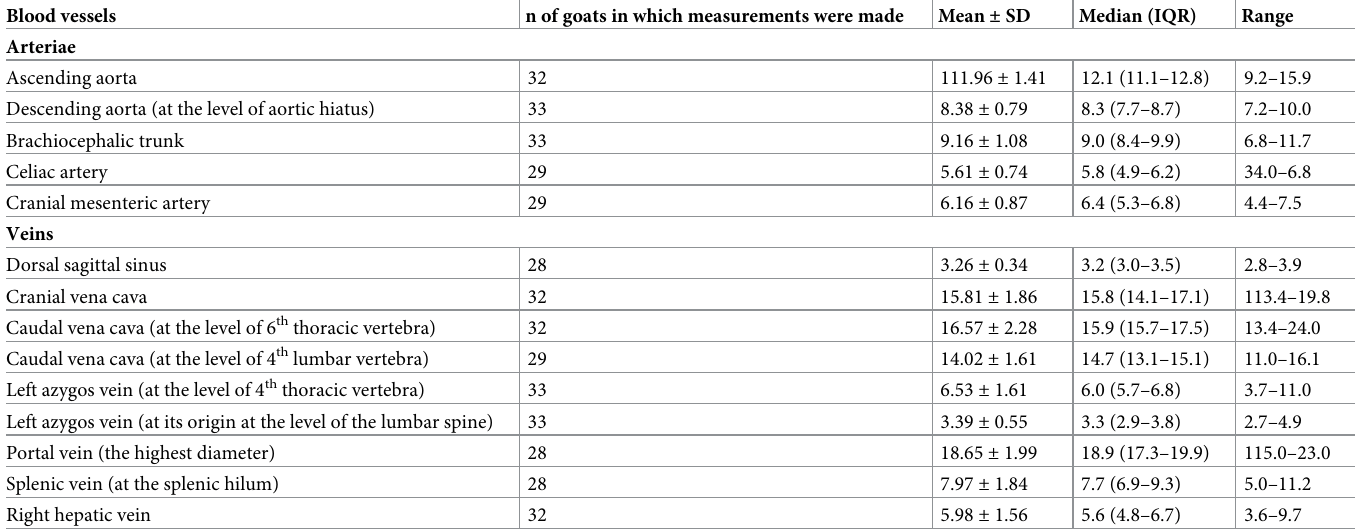
Table 2. Descriptive statistics of unpaired blood vessels measurements (in